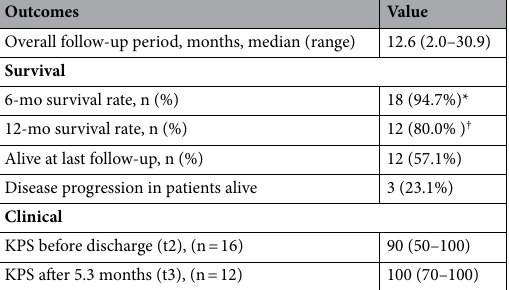
Table 3. Clinical and survival outcomes. *n = 19; in 2 of the 21 patients the 6-months follow-up have not yet been reached. † n = 15; in 6 of the 21 patients the 12-months follow-up have not yet been reached.